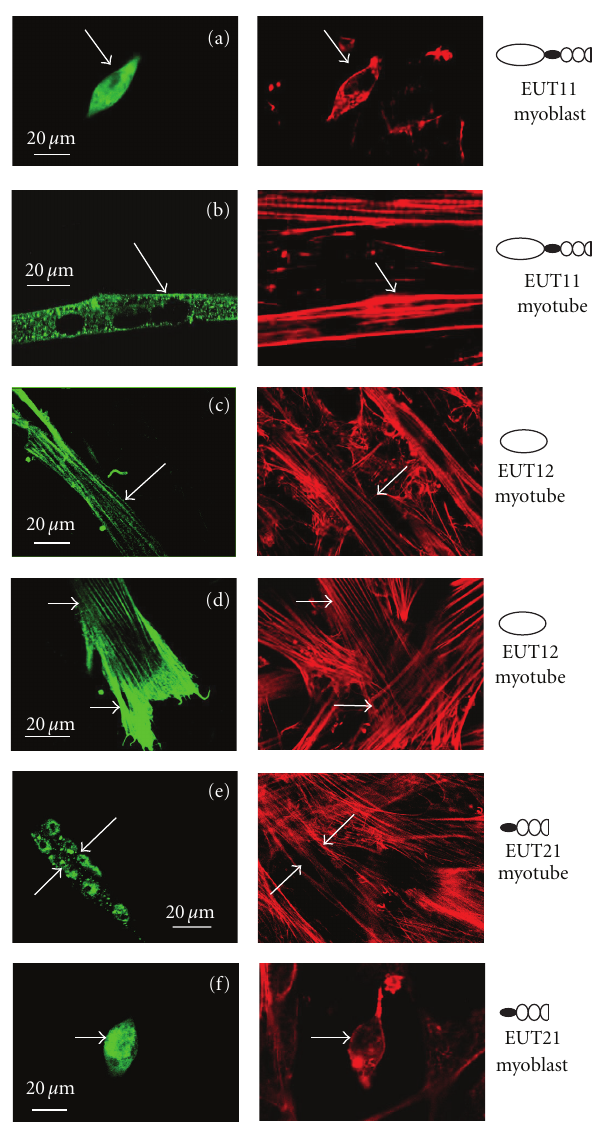
Figure 9: Intracellular sorting of utrophin fragments by expression of eukaryotic vectors in myoblast and myotube primary cultures (EUT11, EUT12, and EUT21, all carrying the FLAG-tag at the C-terminus). In each picture in the left vertical row ((a)–(f)), one transfected cell (green) is present stained with anti-FLAG for the corresponding utrophin fragment. Staining with rhodamine-phalloidin for actin reveals a variable number of red cells in each picture ((b)–(e) in the right vertical row) indicating that the transfected cells often fuse with nontransfected cells when forming myotubes. EUT11 and EUT21 solidly stain nucleus and cytoplasm in single spindle-shaped myoblasts. EUT12 (actin- binding domain) sharply stains actin microfilaments ((c) and (d)) superimposable to the red pattern of actin stain ((c) and (d) at the right). EUT12 also concentrates in regions where actin may attach to the substratum (d). EUT11 distributes over the cytoplasm in a di ff use and punctate manner (b) leaving the myotube nuclei unstained. In contrast, EUT21 is almost exclusively confined to the cell nuclei. For further explanations, see the Methods section and the